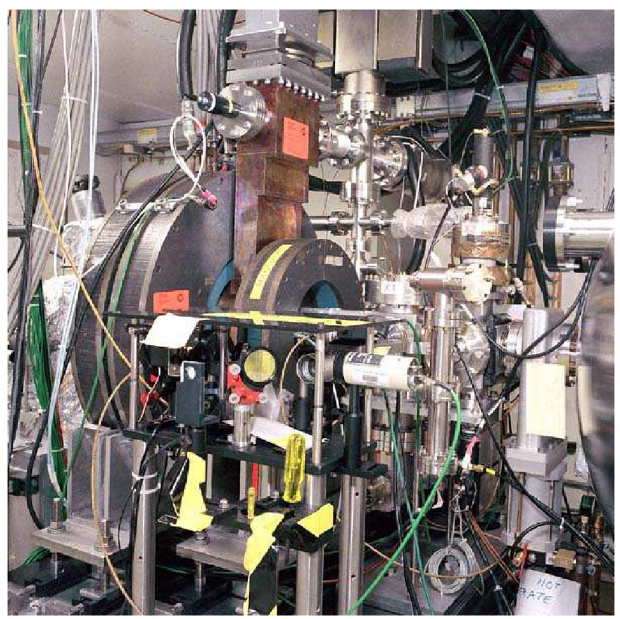
FIG. 1. (Color) The Fermilab rf gun. A small optical table for transport of the laser beam can be seen in the foreground, with the iron yokes for the three solenoids behind it. The waveguide feed for the rf gun is between the primary and secondary solenoids. The first two diagnostic ports of the beam line are to the right of the secondary solenoid; the edge of the cryostat for the 9-cell cavity is at the far